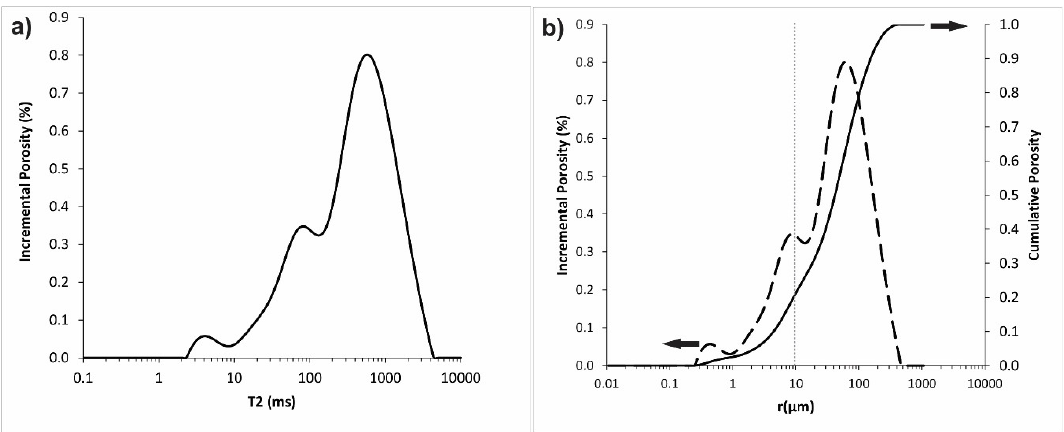
Figure 4. Nuclear Magnetic Resonance (NMR) data from the studied coquina sample. ( a ) shows the T2 distribution and ( b ) illustrates the incremental (dashed curve) and cumulative (full curve) pore size distributions. The vertical dashed line shows the microCT pixel size (9.97 μ m). Pores larger than this value are captured in the digital image. By contrast, pores with a radius smaller than this value are under the image resolution.